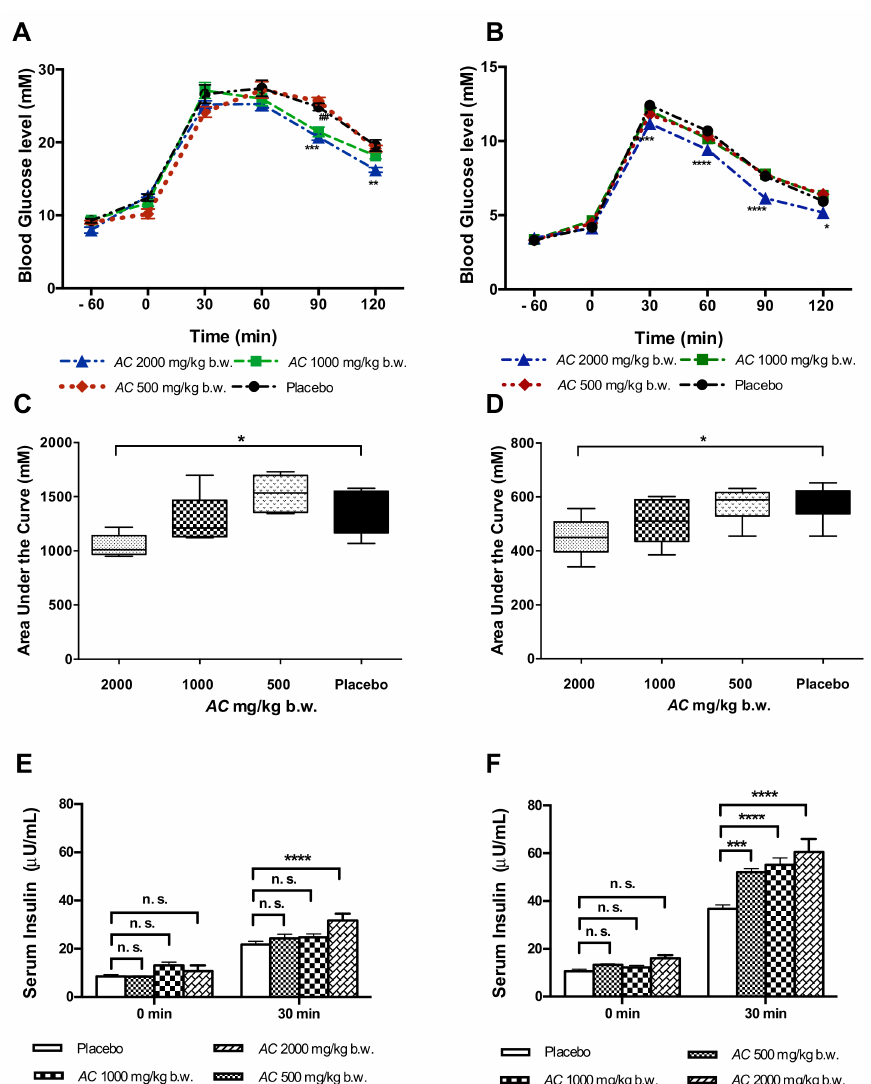
Figure 4. AC improves glucose tolerance and increases serum insulin levels. AC (500–2000 mg/kg b.w.) effect was evaluated during the OGTT in 12 h-fasted, animals received a single oral administration of AC extract one hour before glucose-challenge and glycemia was determined at 0, 30, 60, 90, and 120 min; GK rats ( A ) and W rats ( B ); The AUC of glucose was calculated from time 0 to 120 min in GK rats ( C ) and W rats ( D ); The effect of AC on serum insulin during the OGTT in GK rats ( E ) and W rats ( F